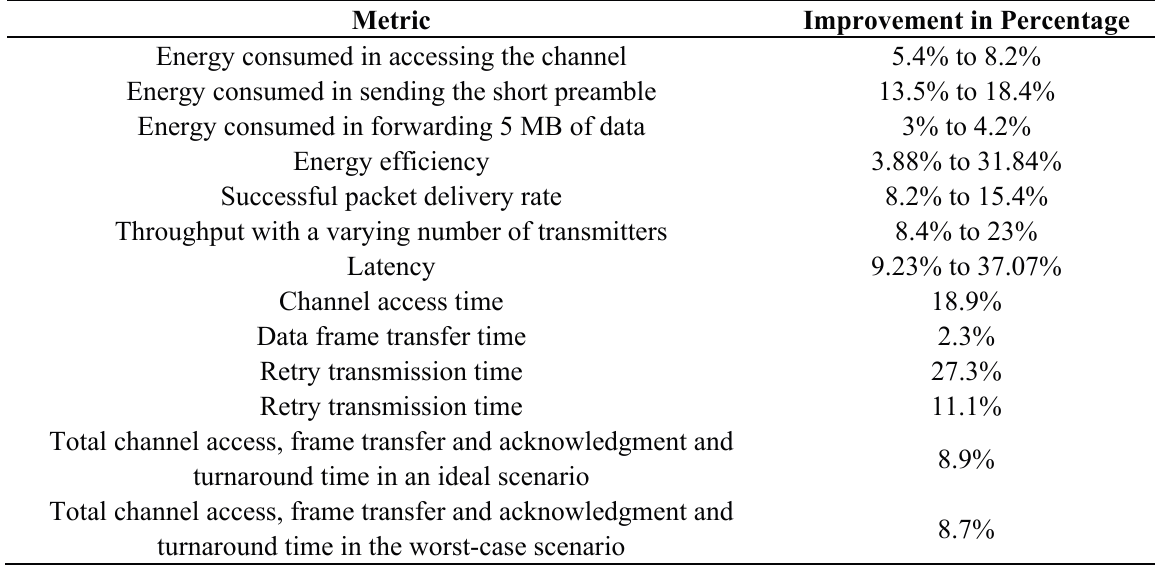
Figure 13. Latency of O-MAC and other competing hybrid MAC protocols with varying mobile speeds. Table 8. The improvement of the proposed O-MAC with the PT model compared with other competing hybrid